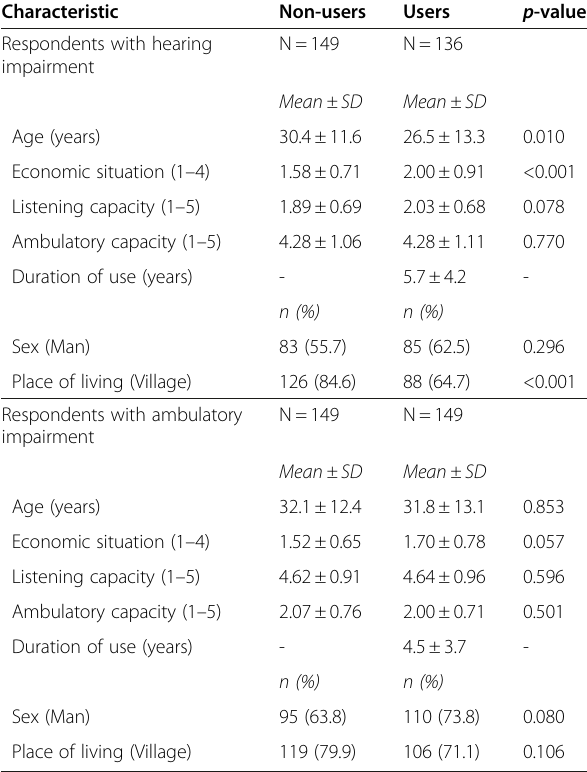
Table 3 Characteristics of non-users and users of hearing aids and